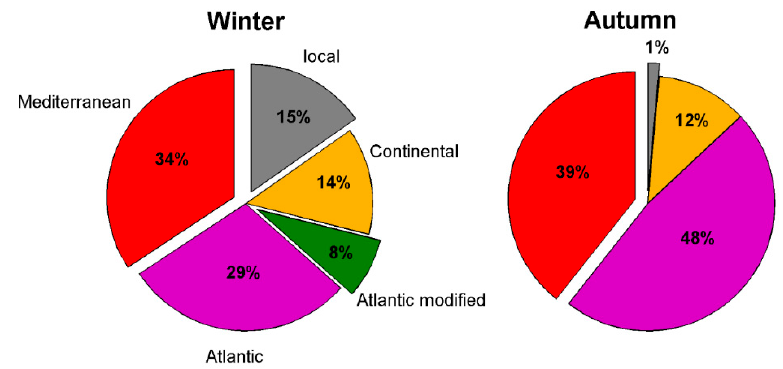
Figure 11. The air masses classification in the FT for winter and autumn seasons: Violet: Atlantic, Green: Atlantic modified, Brown: Continental, Grey: Local, Red: Mediterranean.